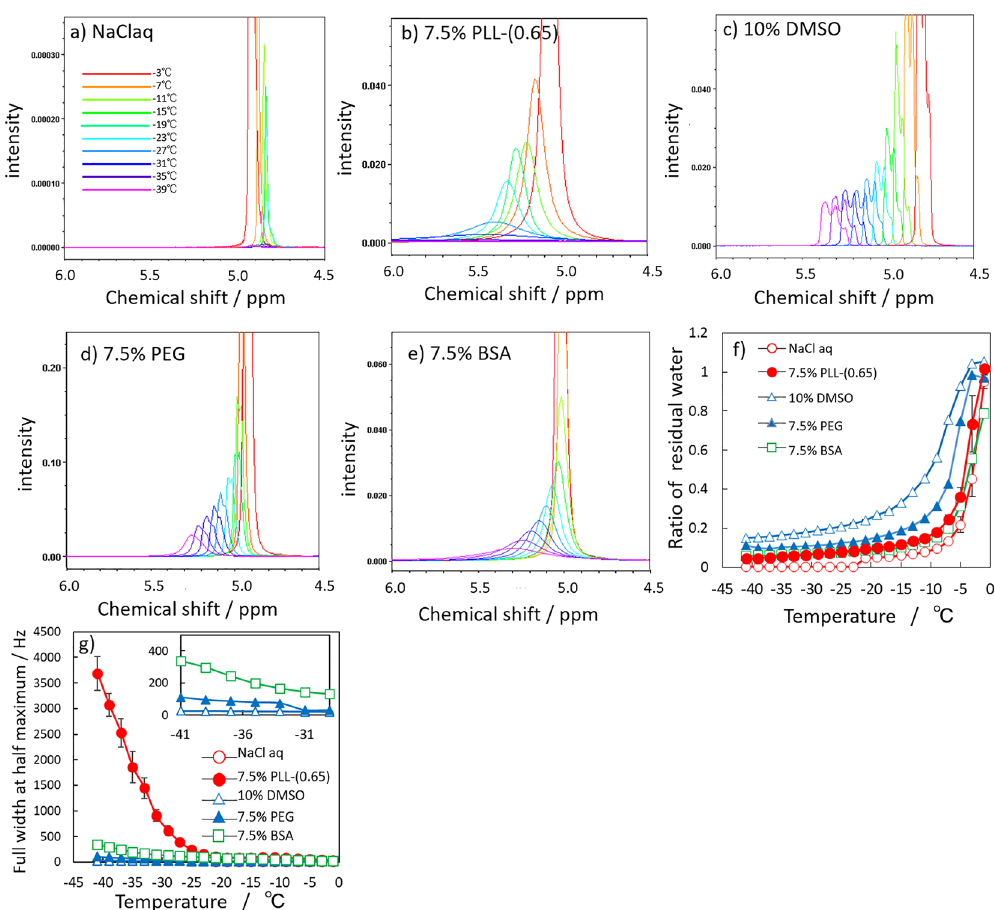
Fig. 2 Residual water determined by solid-state 1 H NMR spectroscopy. a – e 1 H signals of water at various temperatures in a saline solution, b 7.5% PLL- (0.65), c 10% DMSO, d 7.5% PEG. e 7.5% BSA. f , g Temperature-dependent f residual water ratio and g full-widths-at-half-maximum of the proton signals of various solutions. Inset in panel g represents an enlarged view. Error bars represent standard